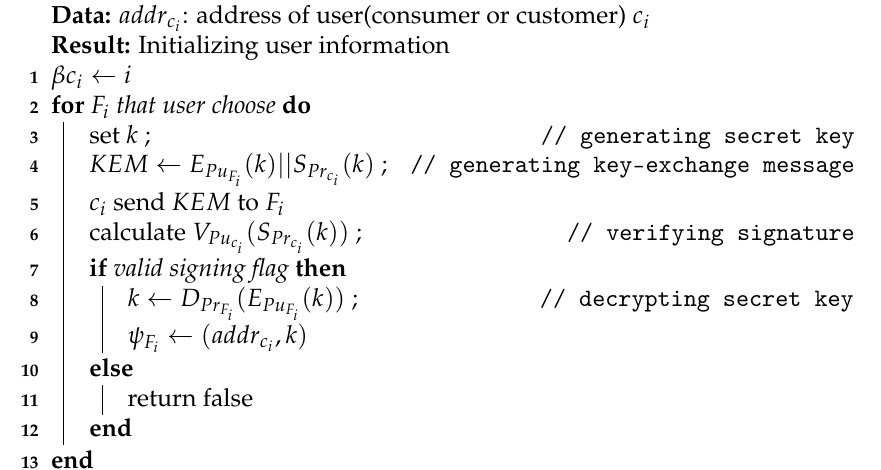
Algorithm 1: Pseudocode of User Management Contract ( UMC